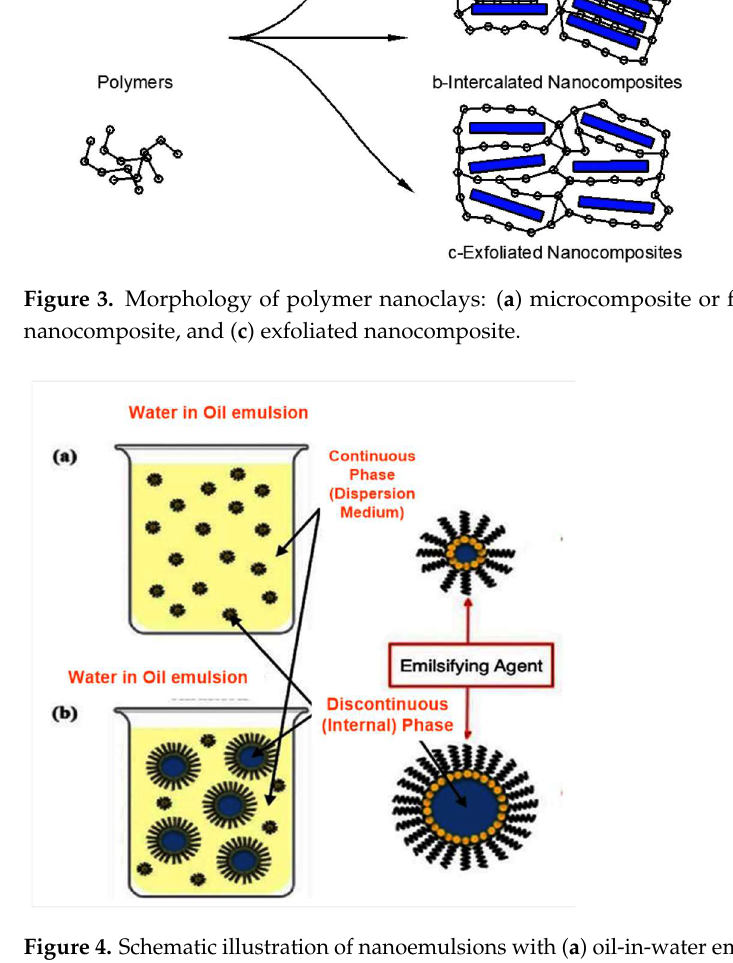
Figure 3. Morphology of polymer nanoclays: ( a ) microcomposite or flocculated, ( b ) intercalated nanocomposite, and ( c ) exfoliated nanocomposite.